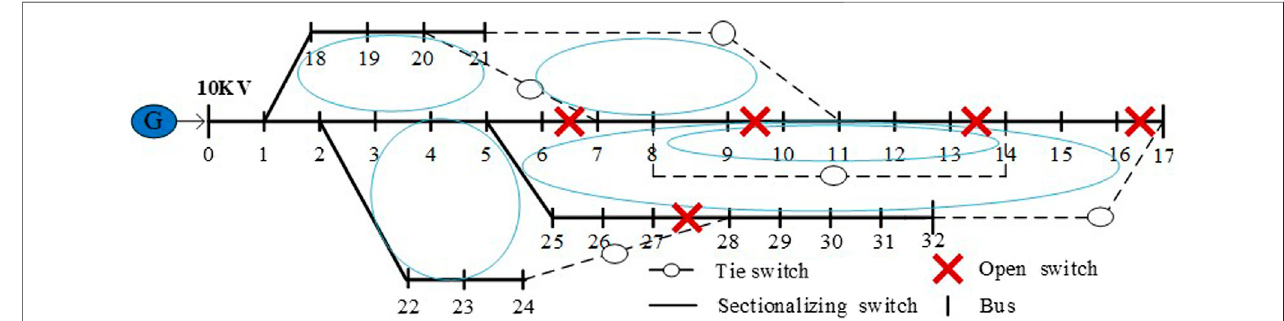
FIGURE 10 | Optimized structure of the distribution system on